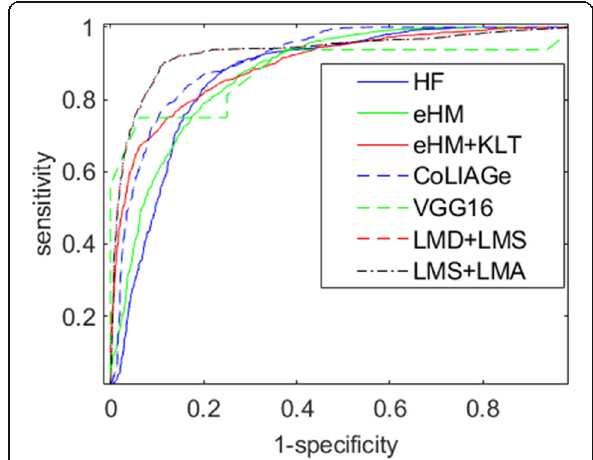
Fig. 8 Receiver operating characteristic curves of six methods via random forest except VGG16. HF: Haralick feature; eHM: Extended Haralick measure; KLT: Karhunen-Loeve transform; LMD: Learning model by multiple displacements; LMS: Learning model by multiple strides; LMA: Learning model by multiple angles; CoLIAGe: Co- occurrence of local anisotropic gradient orientations